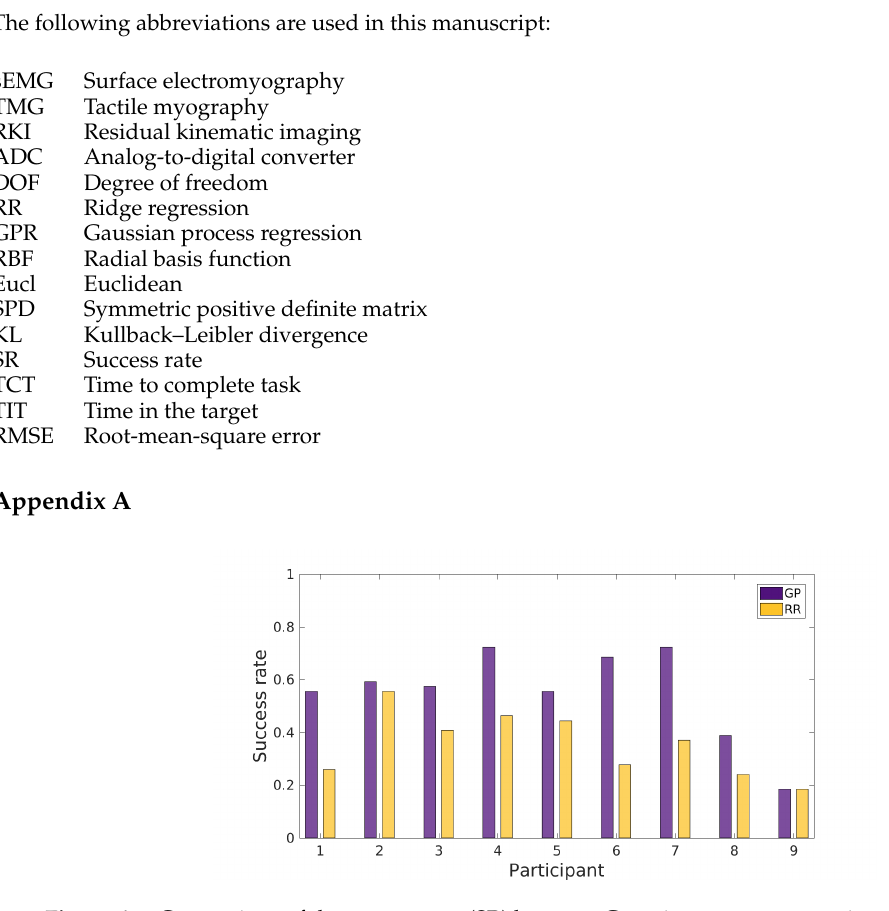
Figure A1. Comparison of the success rate (SR) between Gaussian process regression (GPR) and ridge regression (RR) for each